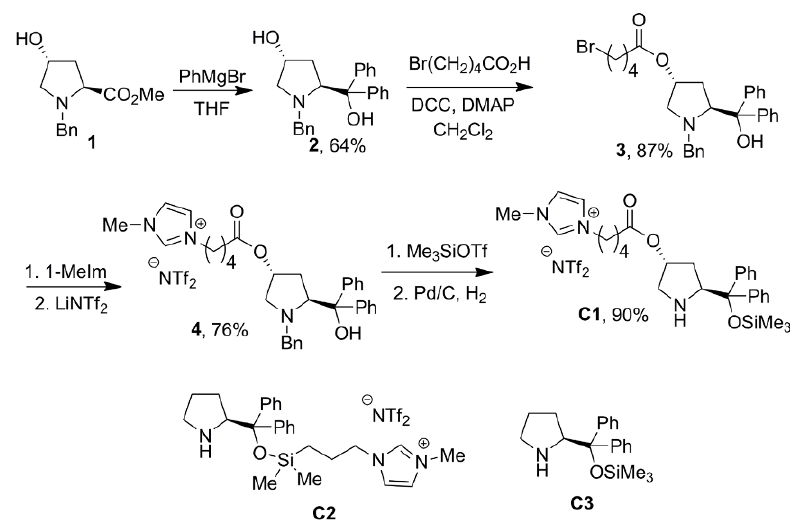
Scheme 1. Synthesis of catalyst C1 , structure of catalyst C2 and C3 .